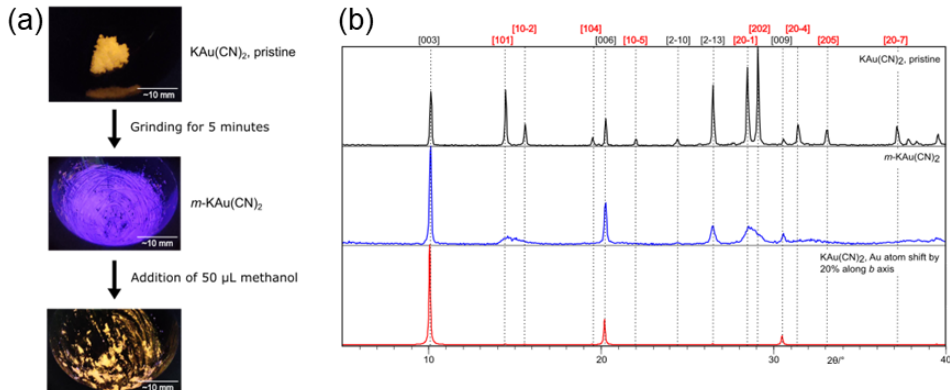
Figure 13. Mechanochemical interconversion of polymorphs of KAu(CN) 2 : ( a ) appearance of a sample of KAu(CN) 2 before and after grinding, and after the addition of a small amount of methanol under ultraviolet light; ( b ) comparison of PXRD patterns (top-to-bottom) of a pristine sample of KAu(CN) 2 , a sample of m -KAu(CN) 2 obtained by grinding and simulated for the structure of KAu(CN) 2 modified to represent disordering of Au(CN) 2 − ions [204] .